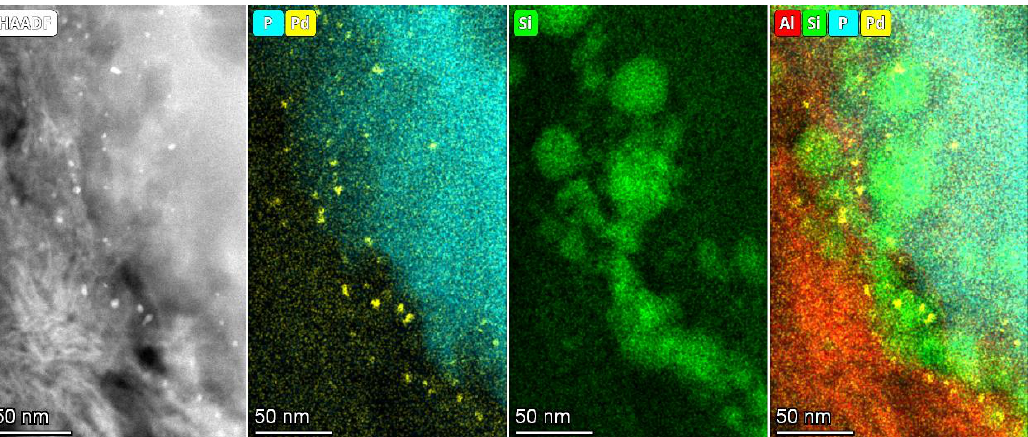
Figure 3. HAADF-STEM image and EDX-maps of an ultramicrotomed sample of reduced Pd-SAPO- 11/ γ -Al 2 O 3 catalyst prepared with the calcination-reduction (CR) method. The elements Pd, P, Si and Al are depicted in yellow, blue, green and red, respectively.